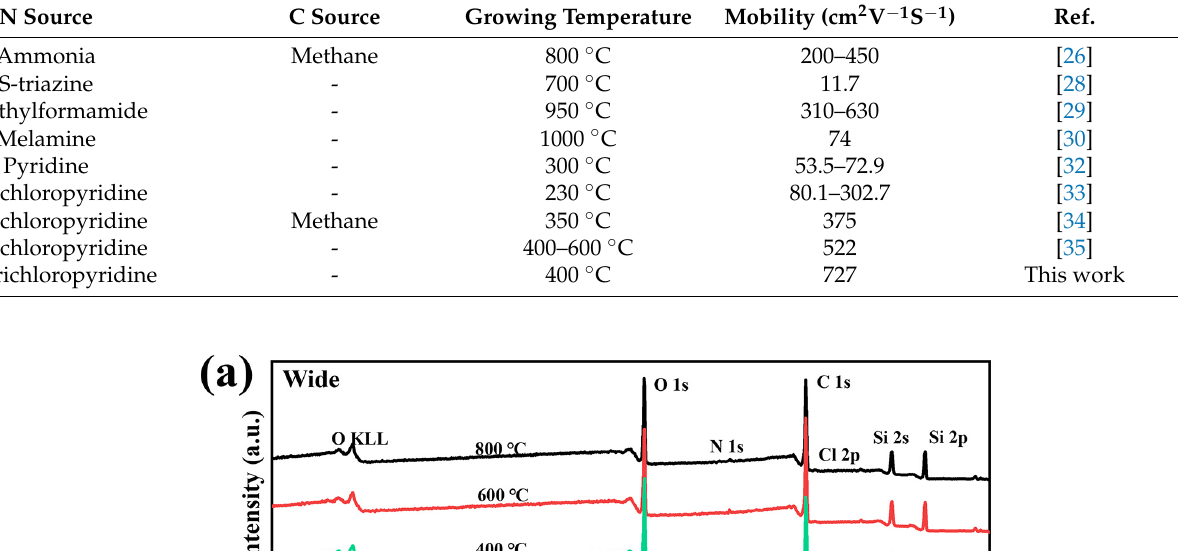
Table 1. Carrier mobility of NG films.